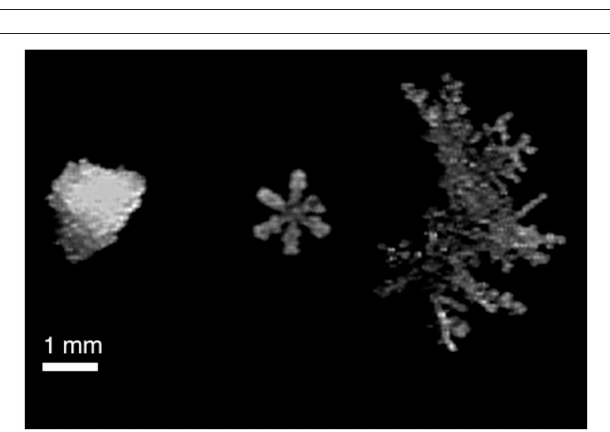
FIGURE 3 | Still image from video of snowmelt, measured daily in 2011 by a LiDAR at CUES. Snow is shown in white and bare ground is shown in green. The video was created by compositing snow free and snow covered daily LiDAR scans during the melt season in 2011. The boxes in the ground are lysimeters. The video is available as supplementary material or at: http:// www.snow.ucsb.edu/data/2011/lidar/.